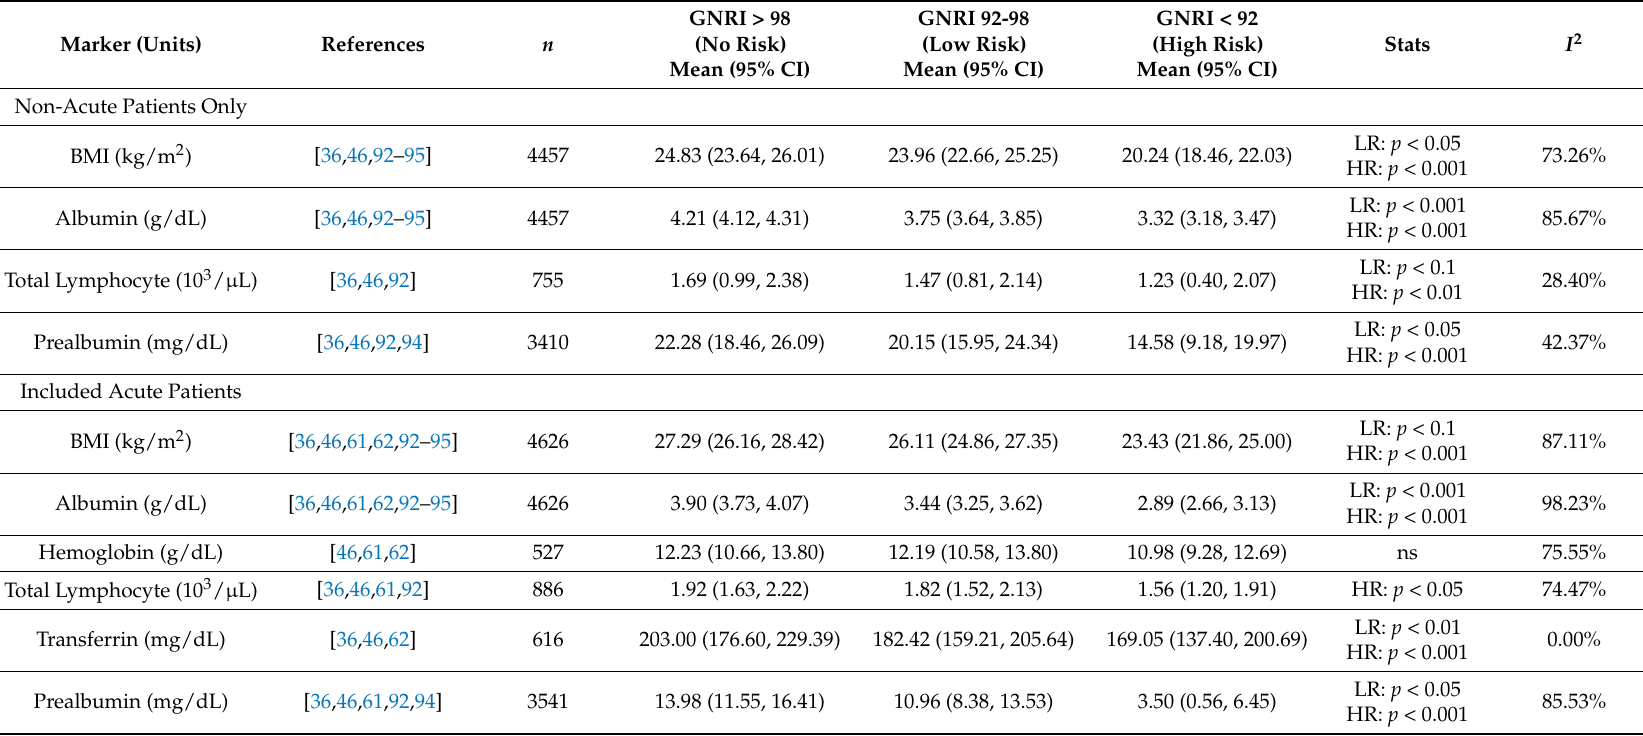
Table 5. Mean biomarker levels in 3subgroups of malnutrition risk status defined by GNRI 1